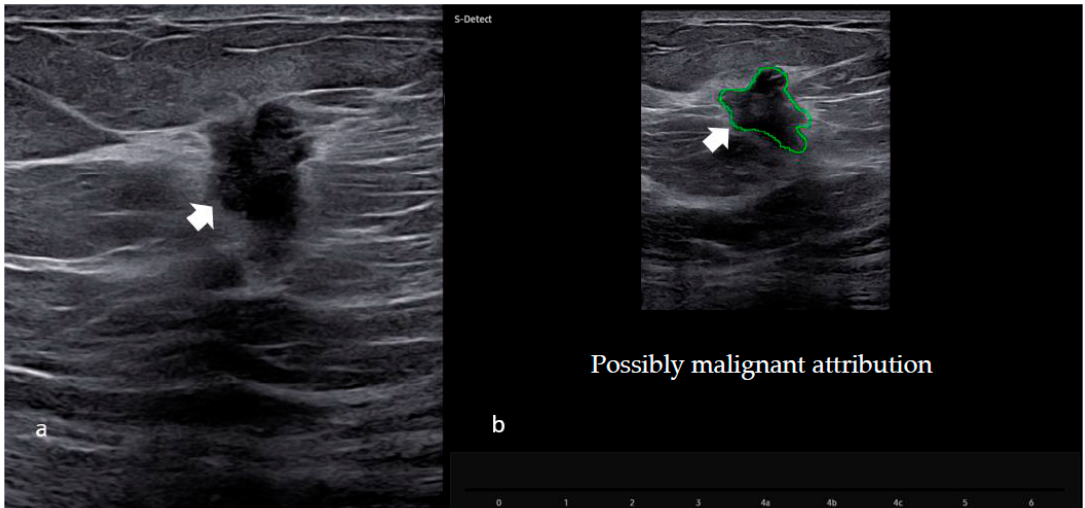
Figure 2. CAD software evaluation (S-detect) in the US images. ( a ) Ultrasound image of the suspicious hypoechogenic nodule with irregular margins in the right breast (as shown by the arrow). ( b ) Region- of-interest (ROI) of the same breast lesion after the S-Detect evaluation. Histological examination of the biopsy confirmed the presence of a malignant neoplasm (invasive ductal